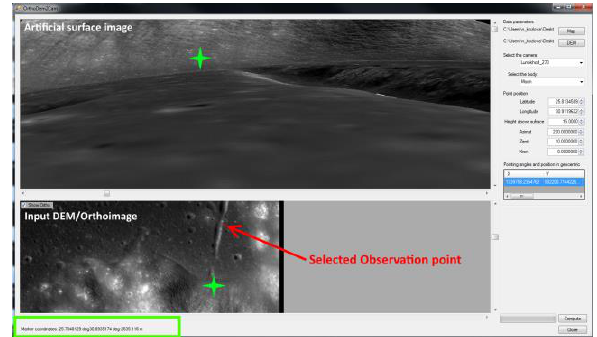
Figure 13. User interface of the OrthoDem2Cam module with example of artificial lunar surface image (upper window) based on LROC NAC DEM on Lunokhod-2 area: observation point is near Fossa Recta groove in Le Monnier